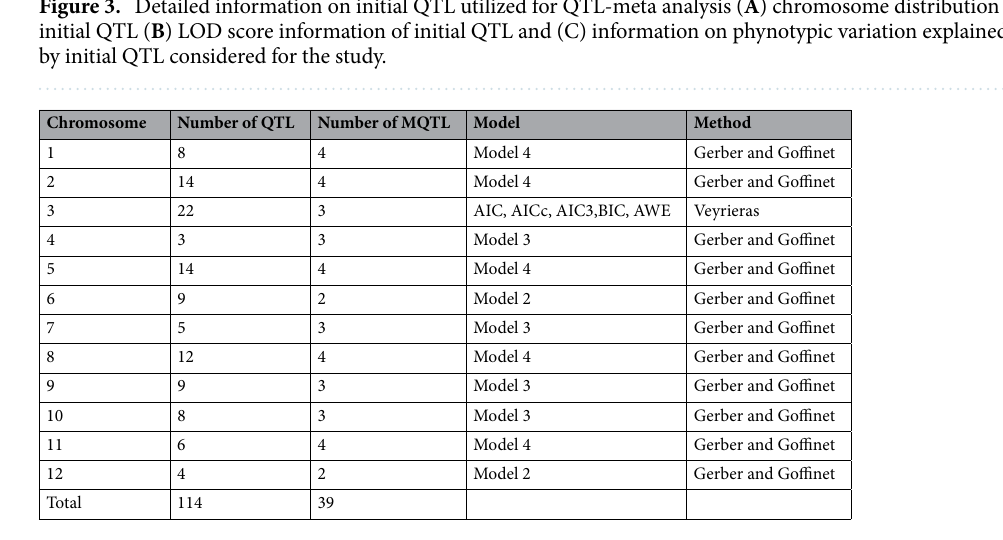
Table 1. Chromosome-wise list of initial QTL and identified